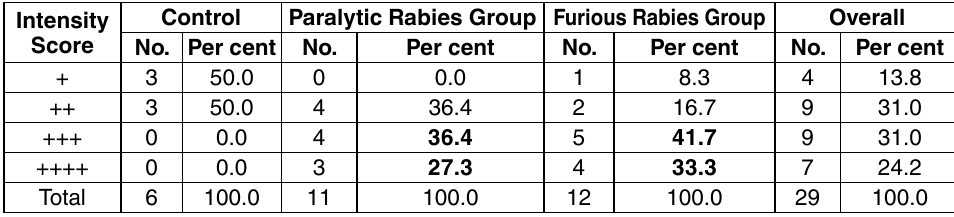
table 1. Classification of cases according to GFAP reactivity control Paralytic Rabies Group Furious Rabies Group intensity score